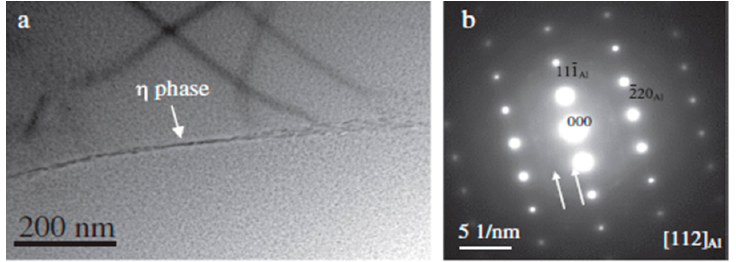
Figure 16. Distribution of grain boundary precipitates of T6 high strength aluminum alloy ( a ) TEM ( b ) SADPs. (Reprinted with permission from ref. [120]. Copyright 2015 Elsevier).